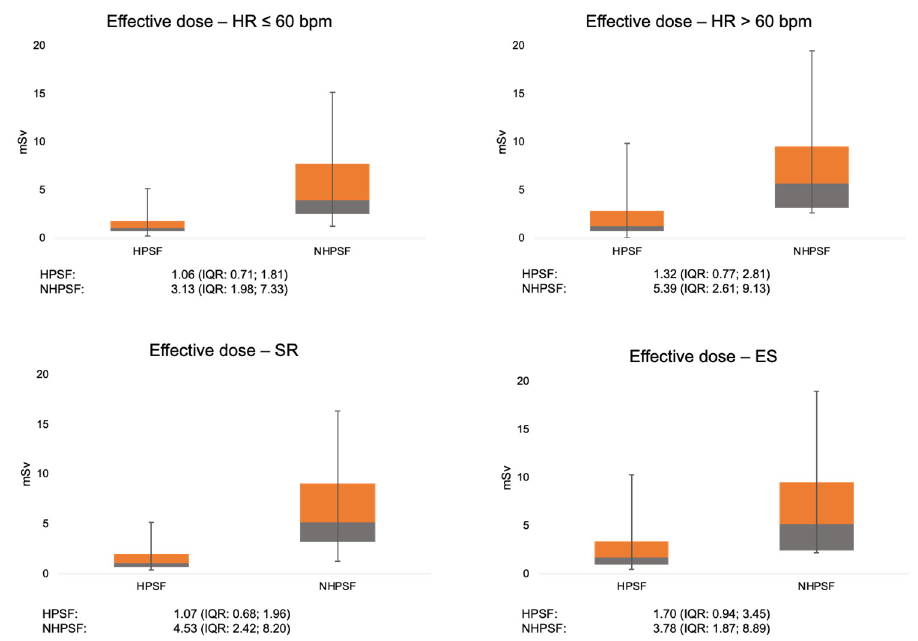
Figure 7. Radiation exposure (median, interquartile-range) for patients investigated with a HPSF and NHPSF approach after dichotomization for heart rate and extrasystoles. HPSF: high-pitch spiral first; NHPSF: non high pitch spiral first; SR: Scheme 0.